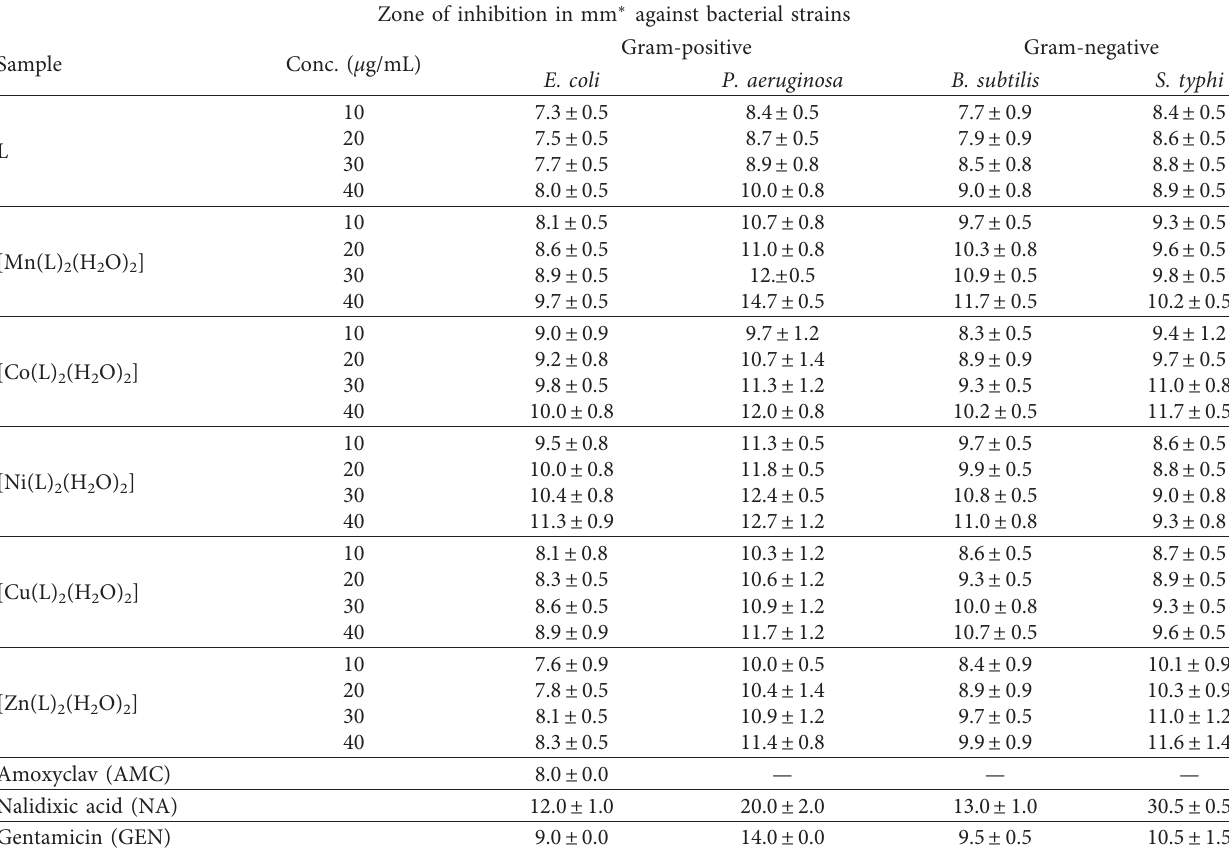
Table 1: Antibacterial screening data for the Schiff base ligand and its metal (II) complexes at concentrations of 10, 20, 30, and 40 µ g/mL. Zone of inhibition in mm ∗ against bacterial strains